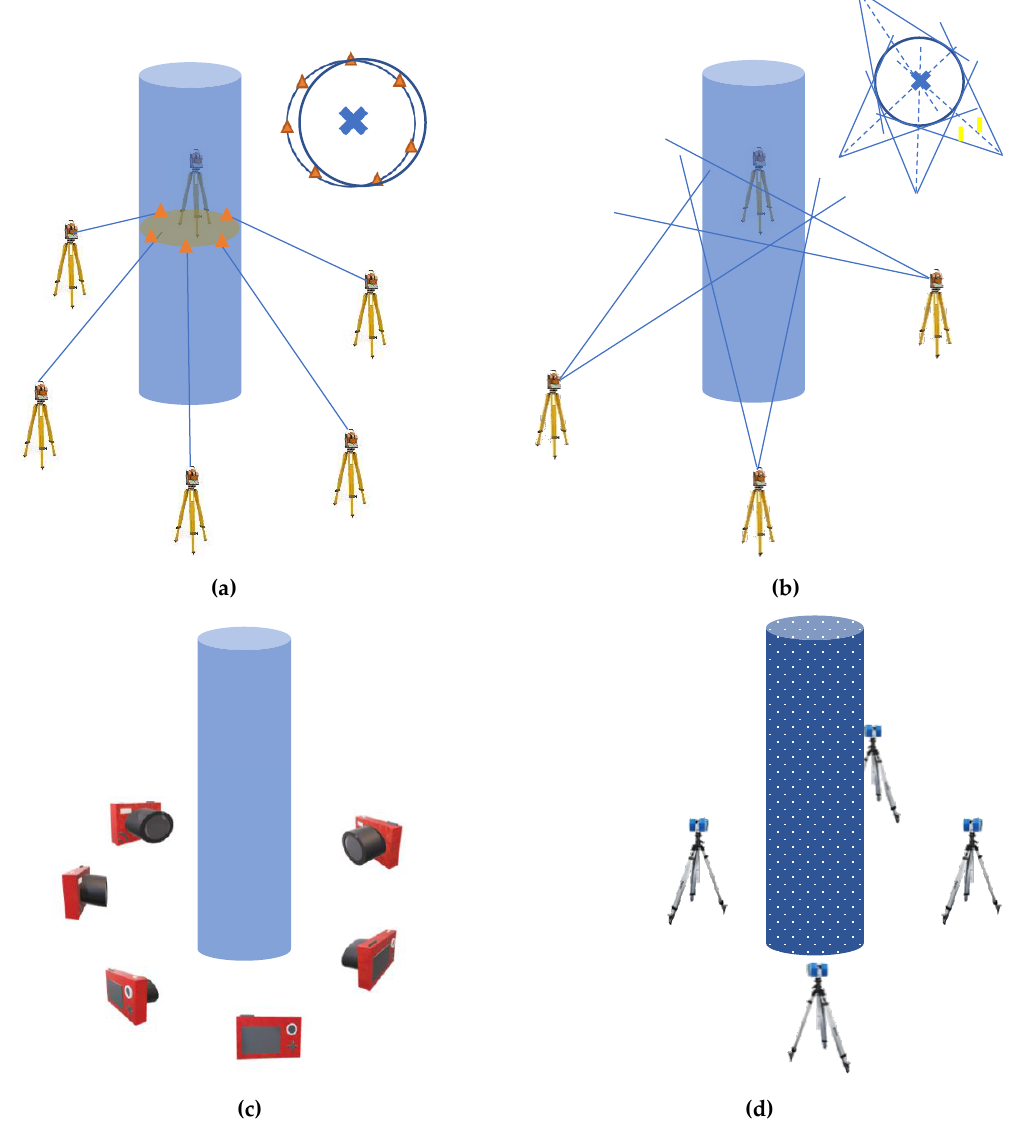
Figure.1 . (a) Geodetic approach using target point measurements. (b) Geodetic approach using angular 63 Figure 1. Different out of plumb monitoring techniques. ( a ) Geodetic approach using target point measurements. (c) Close range photogrammetric approach. (d) TLS approach. 64 measurements. ( b ) Geodetic approach using angular measurements. ( c ) Close range photogrammetric approach. ( d ) TLS